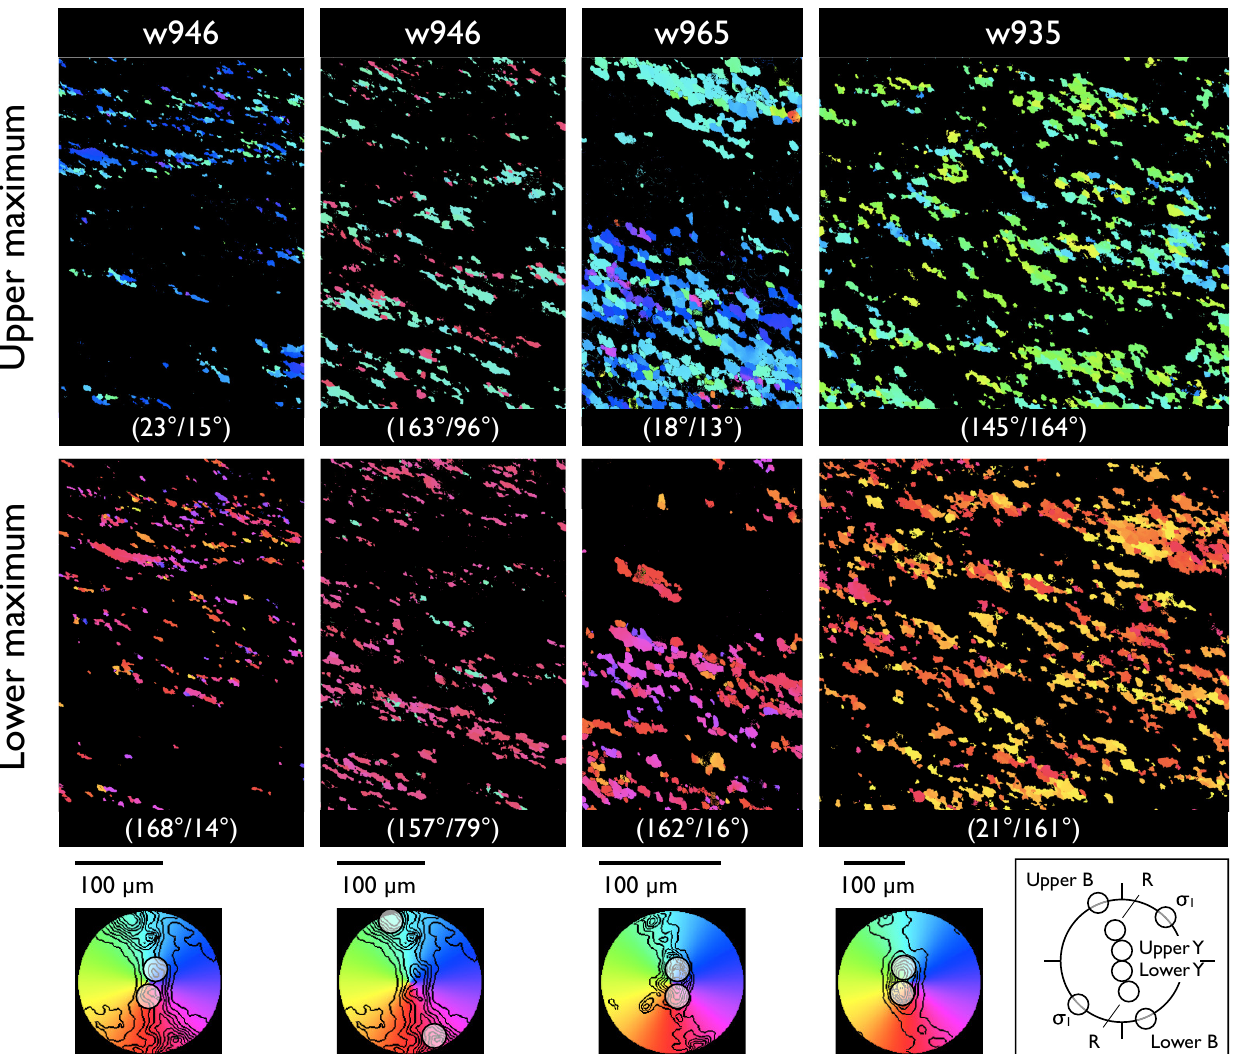
Figure 5. Details of c -axis texture. Color-coded orientation images highlighting the double maxima associated with the B and Y domains. Pairs of domain maps are derived for c -axis orientations within a 30 ◦ cone (15 ◦ opening angle) with respect to the central orientation. The central directions ( c -axis azimuth and inclination) of the submaxima are indicated below the images and correspond to the upper and lower maximum on the pole figure shown at the bottom. Pure azimuth coloring is used for the contoured pole figures and the orientation images. The schematic drawing at the lower right includes preferred c -axis orientations proposed by Heilbronner and Tullis (2006): B (“basal”), R (“rhomb”), Y (“prism”) and the direction of the axial load (at 45 ◦ with respect to the shear zone, usually inferred to be the direction of σ 1